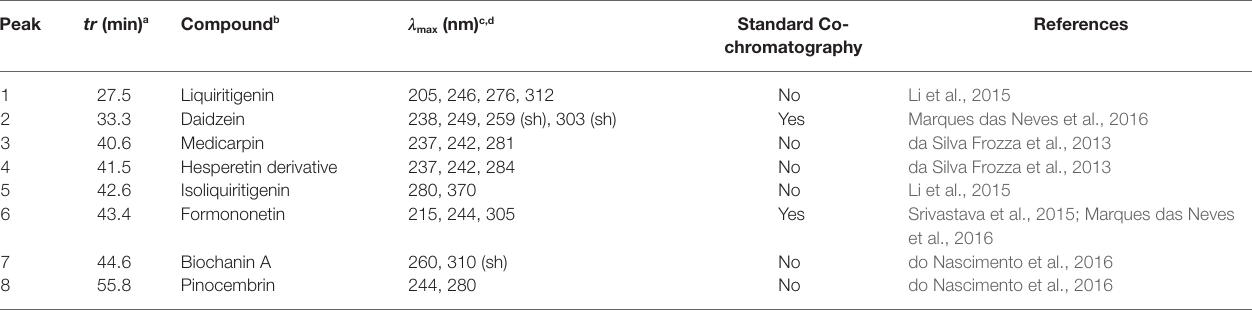
TABLE 4 | Chromatographic and UV-visible (UV-vis) characteristics of the flavonoids identified in the red propolis extract obtained from [C 6 mim]Cl. Peak